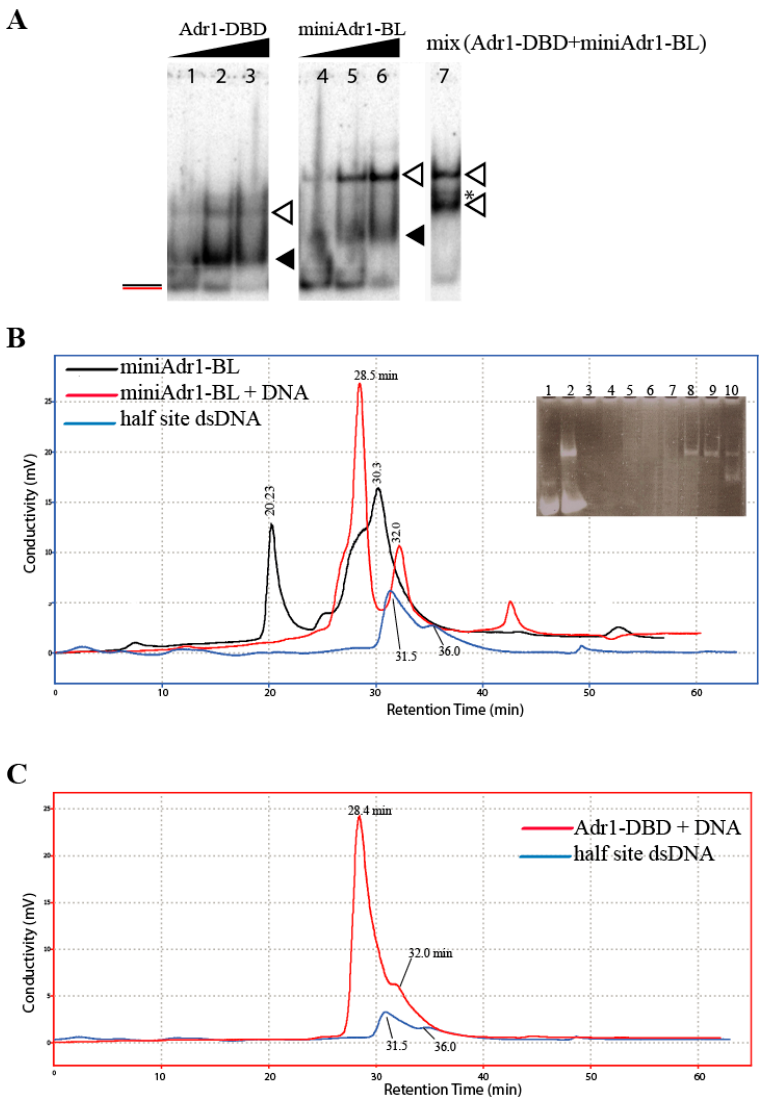
Figure 4. Quaternary assembly and stoichiometry of complex between miniAdr1 constructs and half site dsDNA, investigated with N-PAGE/EMSA ( A ) and SEC ( B , C ). ( A ) Effect of protein concentration on DNA binding in the absence of CHAPS and in the presence of half site dsDNA. Lanes 1–3: Adr1-DBD (20, 40, and 80 pmol). Lanes 4–6: miniAdr1-BL (20, 40, and 80 pmol). Lane 7: stoichiometric mixture of both proteins (40 pmol). The white arrowhead points to the homodimers, the black arrowhead to the monomers, and the asterisk to a putative heterodimer complex bound to the half site dsDNA. ( B ) Overlay of elution profiles of the half site dsDNA probe alone (blue chromatogram), miniAdr1-BL alone (black), and in complex with the half site dsDNA probe (red). Retention times (in minutes) corresponding to the peaks are marked. Insert: EMSA of SEC-collected fractions of the miniAdr1-BL+DNA complex (red chromatogram), revealed by ethidium bromide staining. Lane 1: fraction eluted at 32 min (free half site DNA probe). Lane 2: input to the gel filtration column for SEC experiment. Lane 3–7: fractions eluted between 20 and 27 min retention time. Lane 8: fraction eluted at 28 min. Lane 9: fraction eluted at 29 min. Lane 10: fraction eluted at 30 min. ( C ) Elution profiles of the half site DNA probe alone (blue chromatogram) in overlay with the profile of Adr1-DBD in complex with the half site DNA probe (red chromatogram). Retention times (in min) corresponding to the peaks are marked.